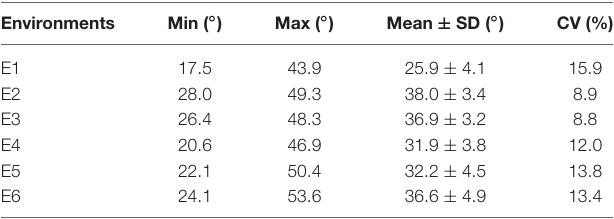
TABLE 2 | Phenotypic variation in branch angle for a rapeseed association population in six environments.